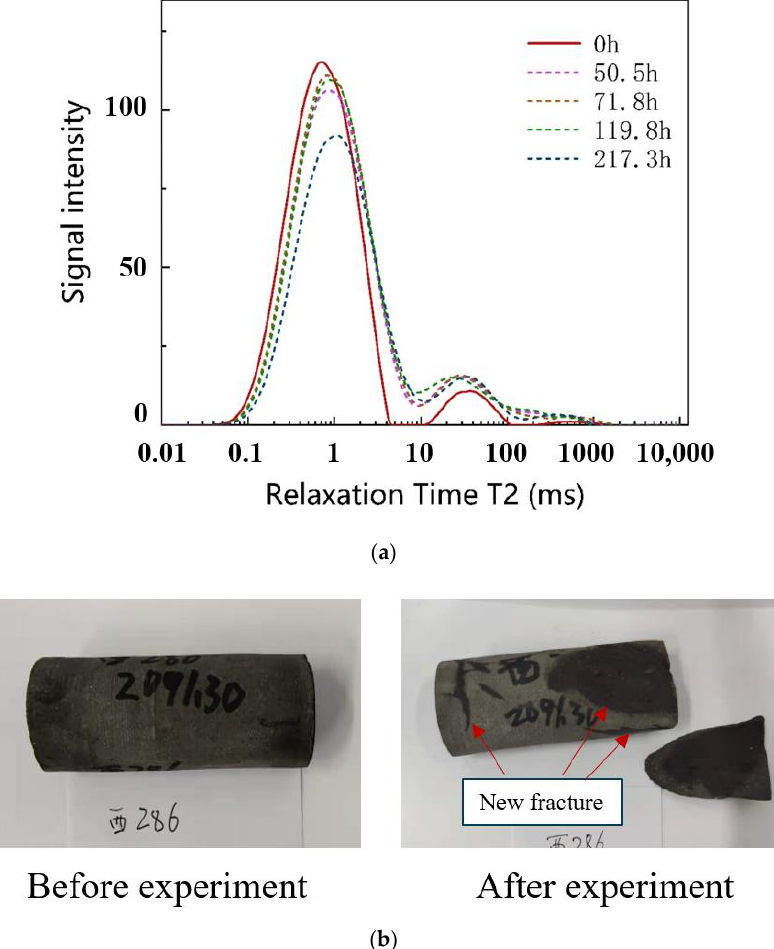
Figure 12. Development of T 2 of sample XBL under 10 MPa. ( a ) The development of T2 with time; ( b ) The new fracture on the surface of the sample after the experiments. ( b ) The new fracture on the surface of the sample after the